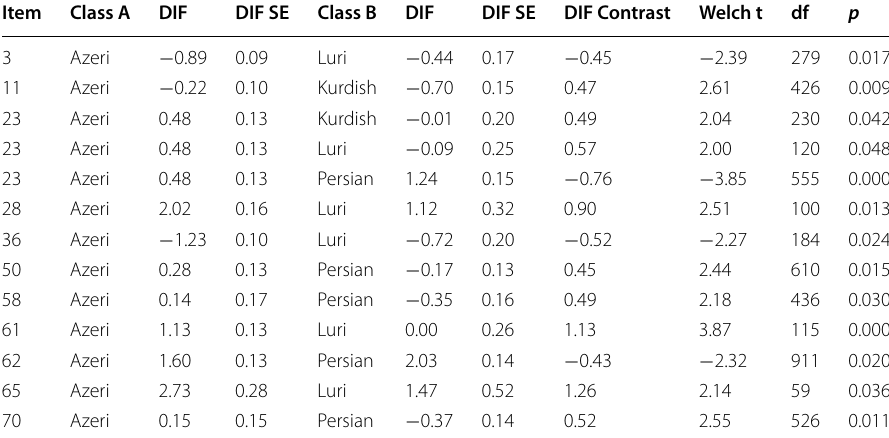
Table 3 Results of uniform DIF analysis of items (IUUESEE 2016)